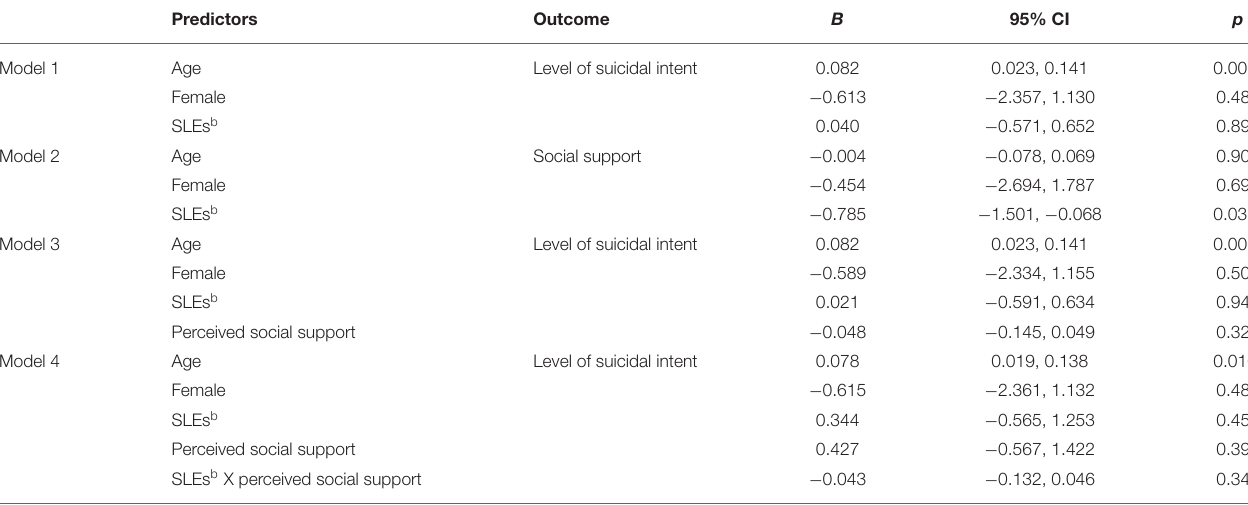
TABLE 3 | Linear regression results from mediation and moderation analyses with level of suicide intent as the outcome a .